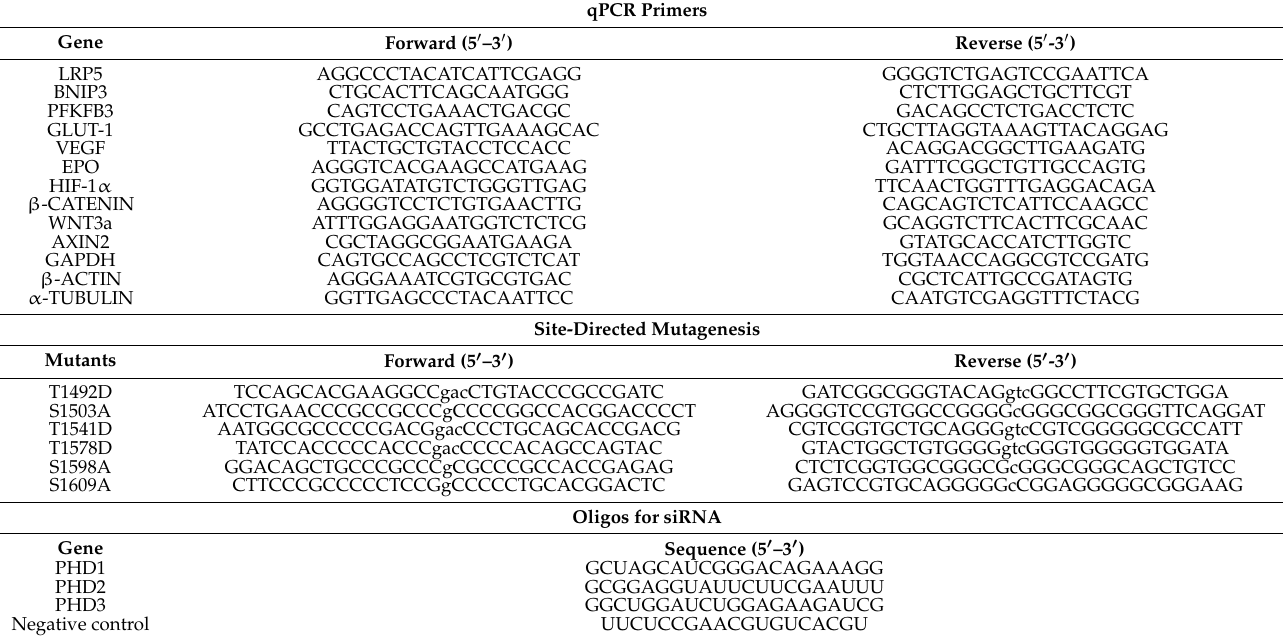
Table 1. List of primers and oligos used for qPCR, site-directed mutagenesis, and siRNA